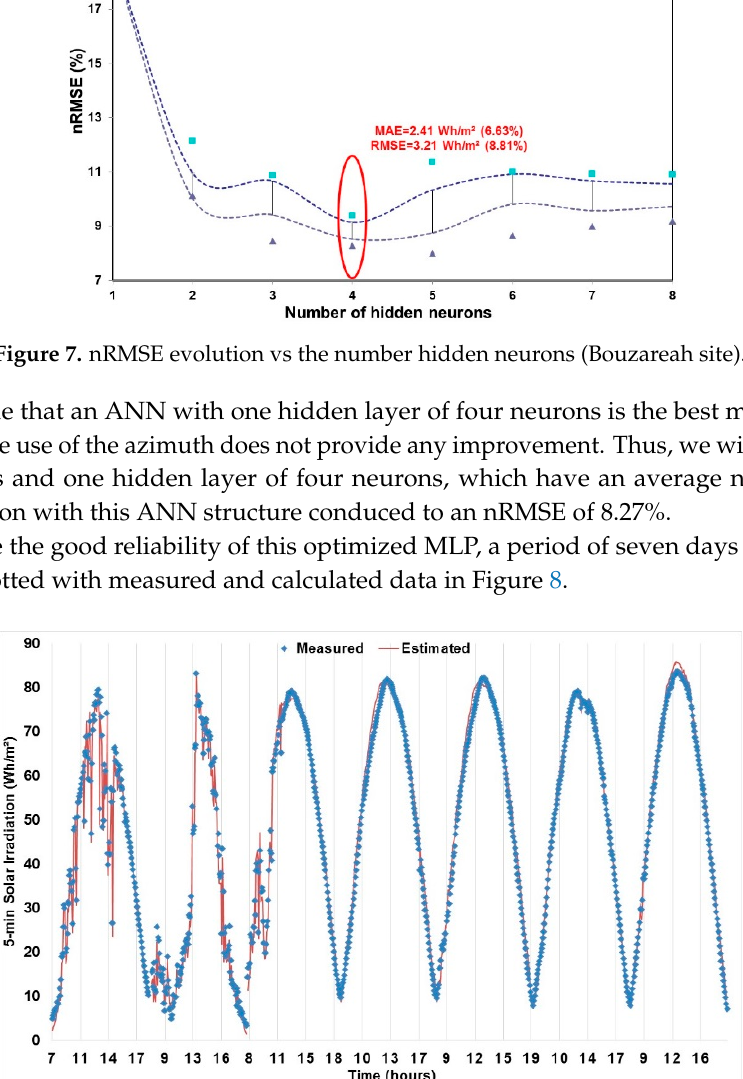
Figure 7. nRMSE evolution vs the number hidden neurons (Bouzareah site).